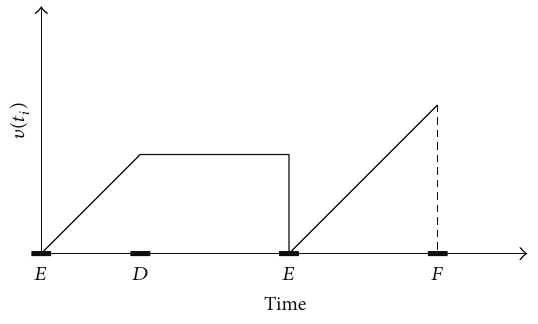
Figure 6: Time elapses, 𝑡 𝑖 is a noninterruptible